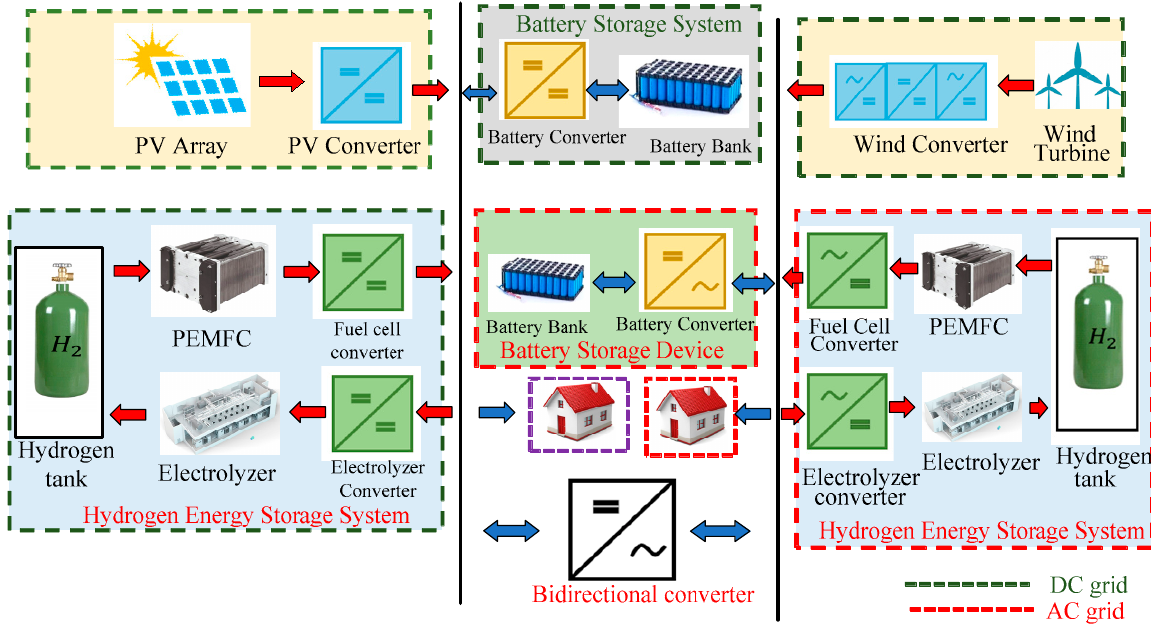
Figure 4. Multi energy storage system in HMG [94].